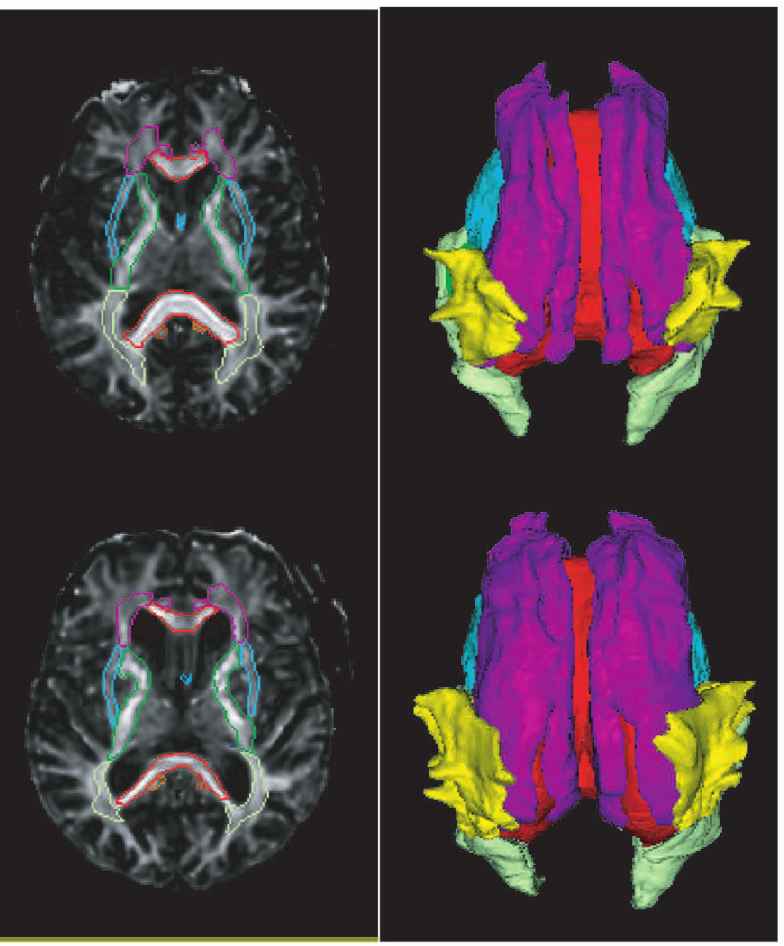
Figure 1. Examples of the white matter tract segmentation. Rows respectively illustrate the white matter tracts of a healthy elderly subject and a patient with AD. The left column shows the volume representation in the FA maps, while the right column shows the surface representation in the superior view.